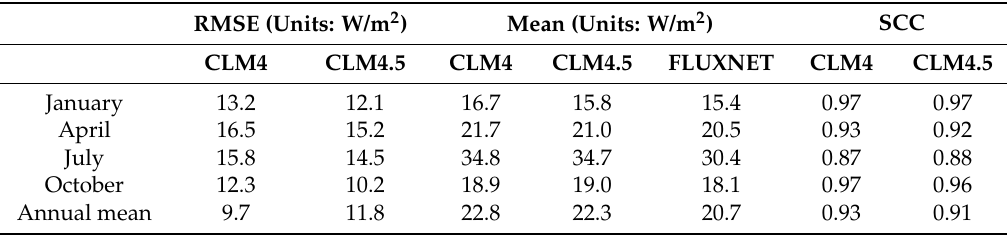
Table 5. RMSE, means and spatial correlation coefficients (SCC) for globally latent heat flux in January, April, July and October and annual